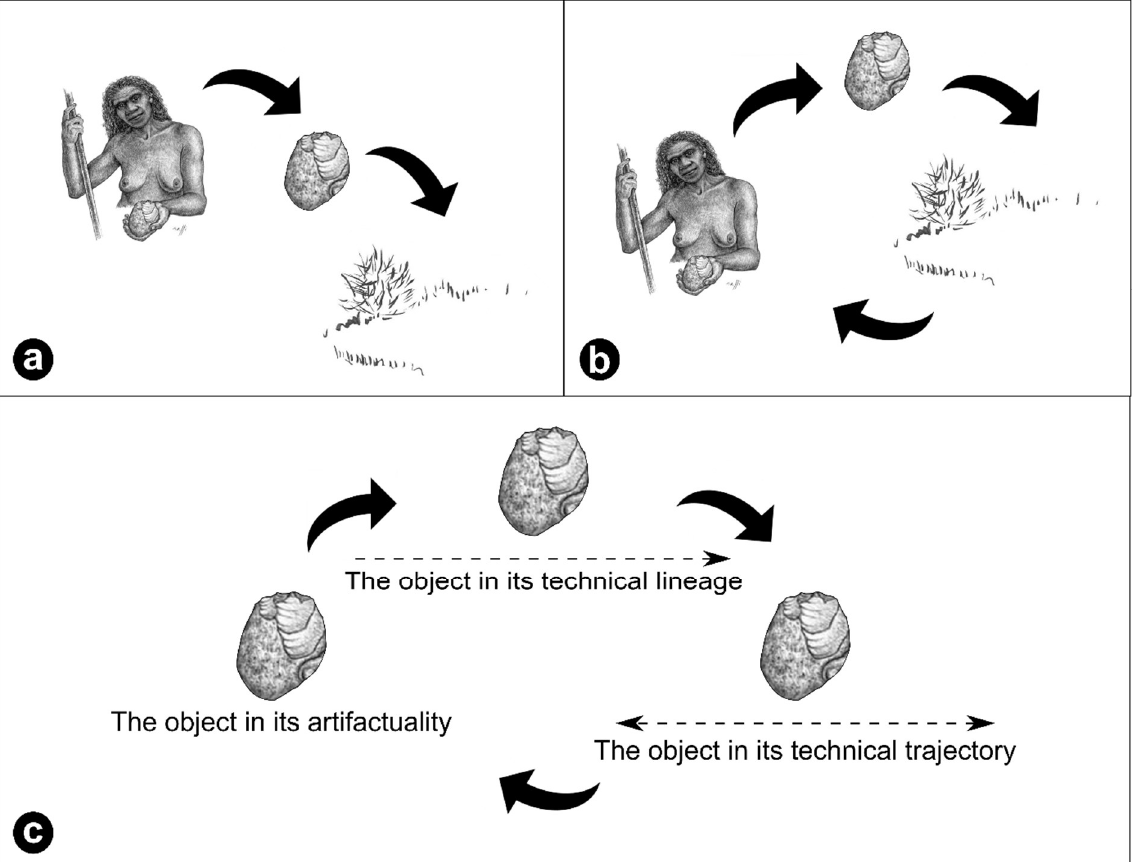
Figure 1. Different types of relationships between humans, artefacts and the environment: (a) the usual case of epistemologies in anthropology that consider the human being as the master and owner of nature. In this conception, the object is only an intermediary between the human being and the environment. (b) The more recent case of certain epistemologies in anthropology that consider a symmetrical relationship between the human being, the object and the environment. (c) The case of the epistemology of relational realism, proposed in this article. In prehistory, in the absence of living individuals, the object enters into a symmetrical relationship with its technical lineage and with its technical trajectory, thus defining, all three, a technical genesis. The object exists not only because it was produced by human beings, but also because it is in constant technical evolution (lineages) and in constant historical evolution (trajectories). In other words, the object that we perceive is nothing more than the stable manifestation of a set of unstable technical relations of a much more fundamental character. We also refer to this set of relationships as “technicality”. The drawings were made by Maxence